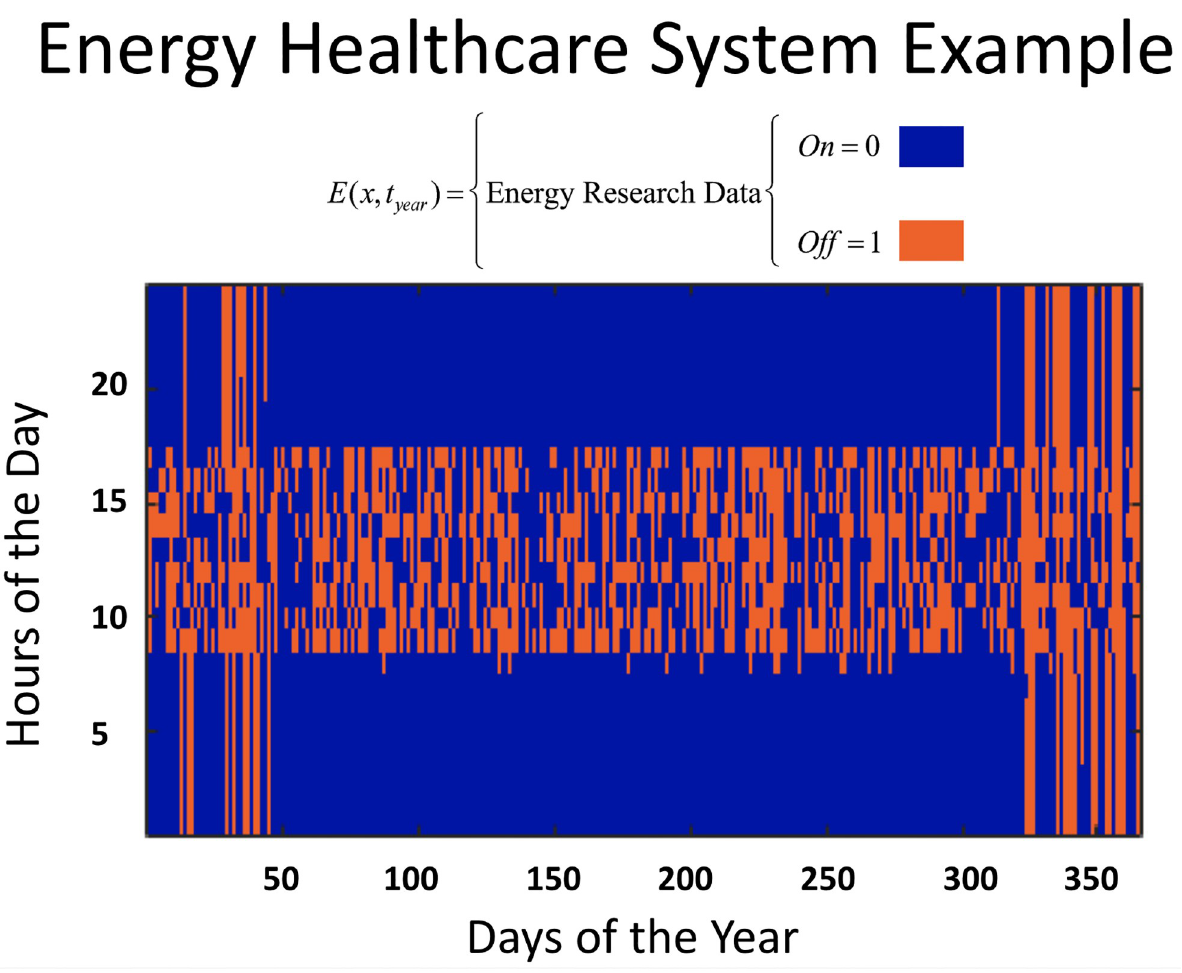
Fig 2. lectricity failure events (red) for Iraq Rural health care facility published in Solar Energy, 2010 [16]. Hours of the day on the y-axis and days of the year on the x-axis with color showing state of electricity system: on (blue) or off (red).